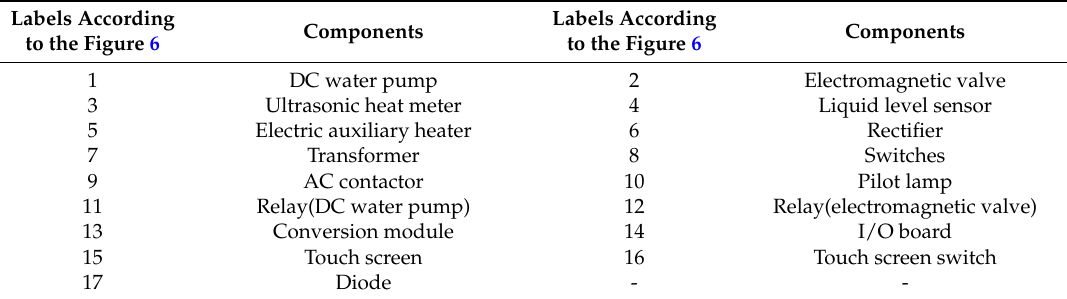
Table 5. The components according to the Figure 6.